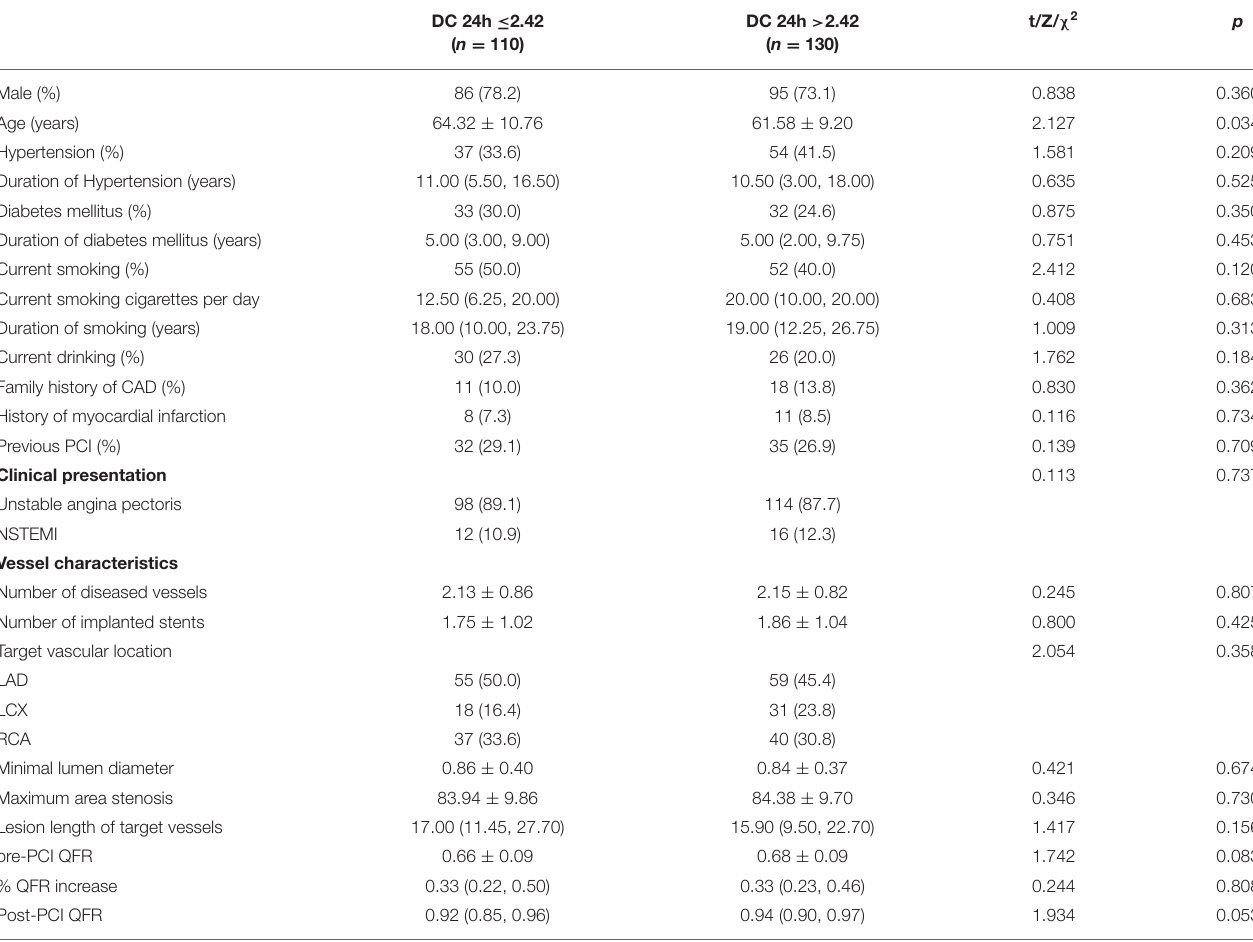
TABLE 1 | Comparison of patient information and target vessel characteristics according to 24-hour deceleration capacity.